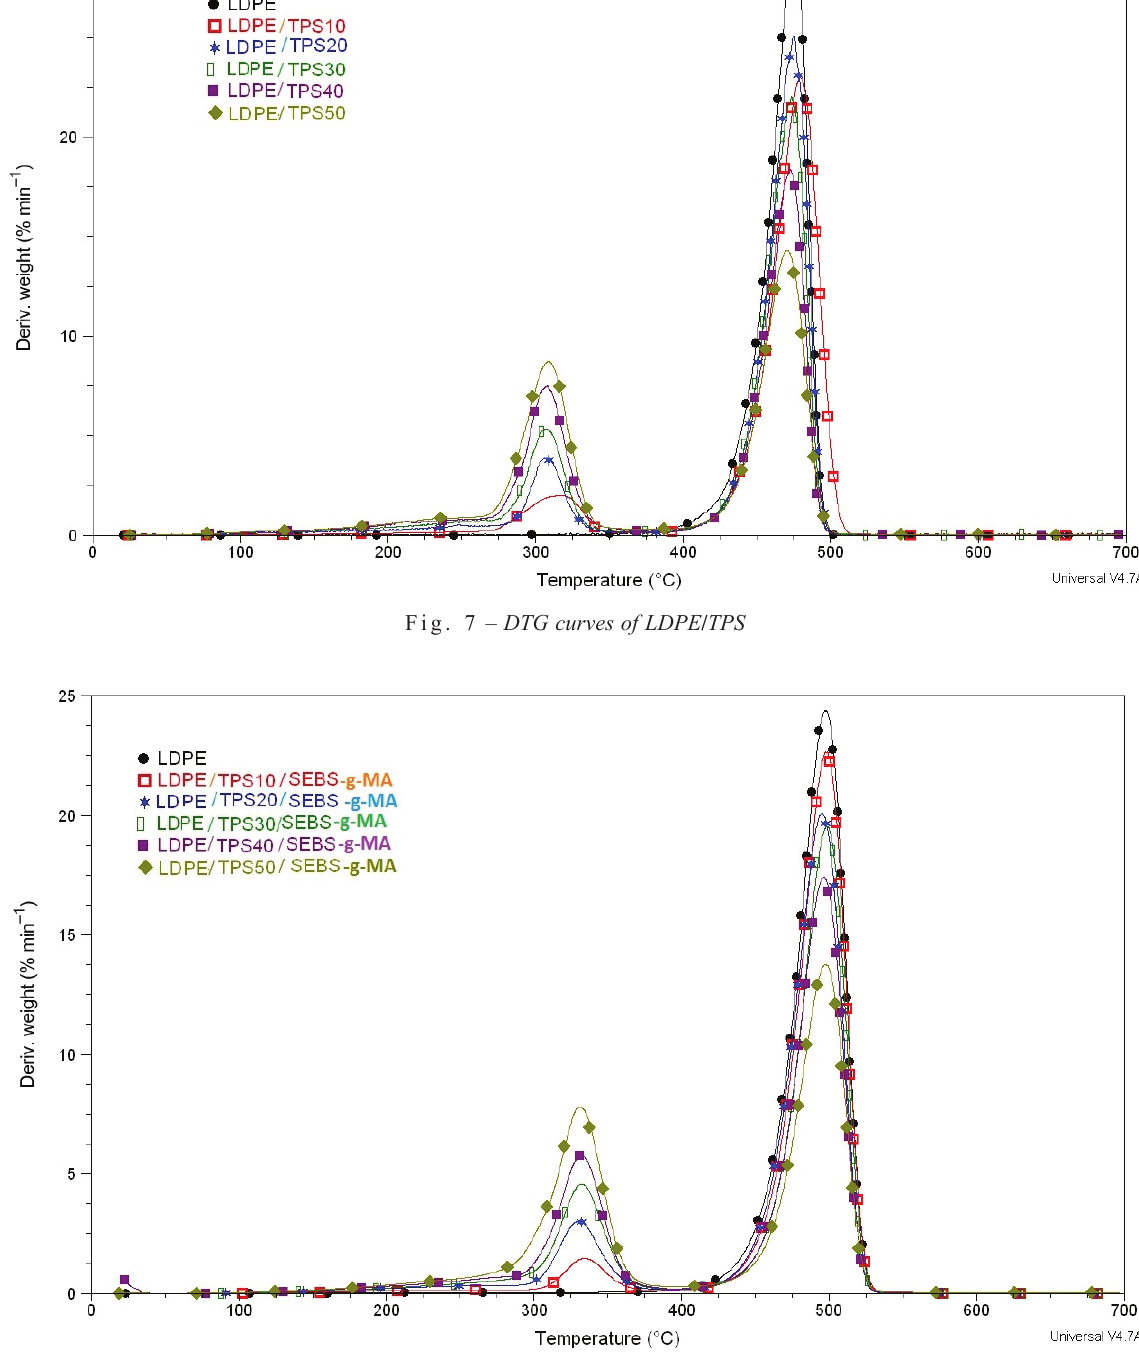
Fig. 8 – DTG curves of LDPE / TPS/SEBS-g-MA